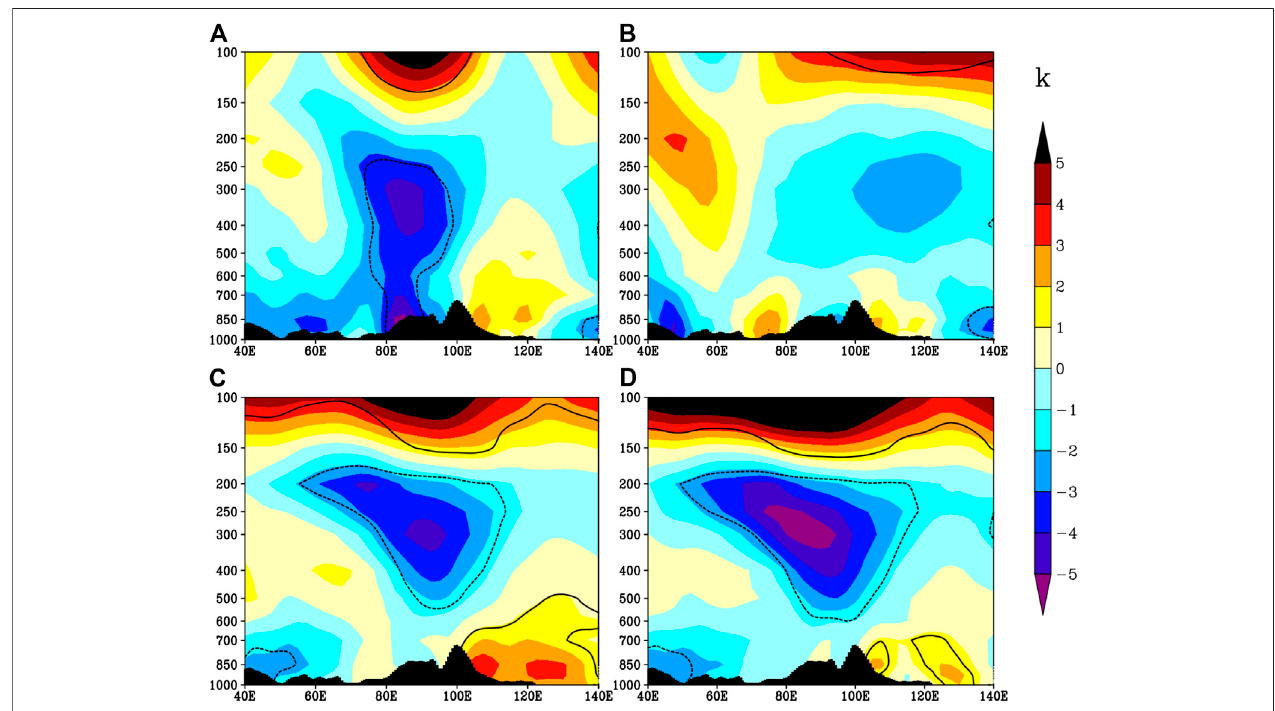
FIGURE13| Regressionmapsofthepressure – longitudecross-sectionoftheAM-meanairtemperature(shaded;unit: K)averagedbetween20 ° and30 ° Nagainst the (left) BOBSM onset time and (right) SCSSM onset time for (upper) 1958 – 1979 and (bottom) 1980 – 2018. The areacircled byblack linedenotes values exceeding the 90% con fi dence